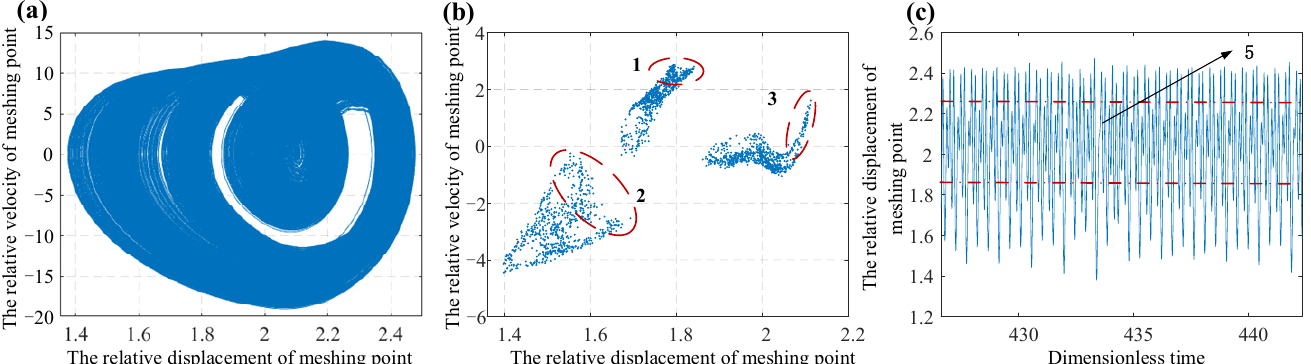
Figure 10. System response diagram with D = 1.43. ( a ) Phase diagram. ( b ) Poincare section diagram. ( c ) Time domain diagram.